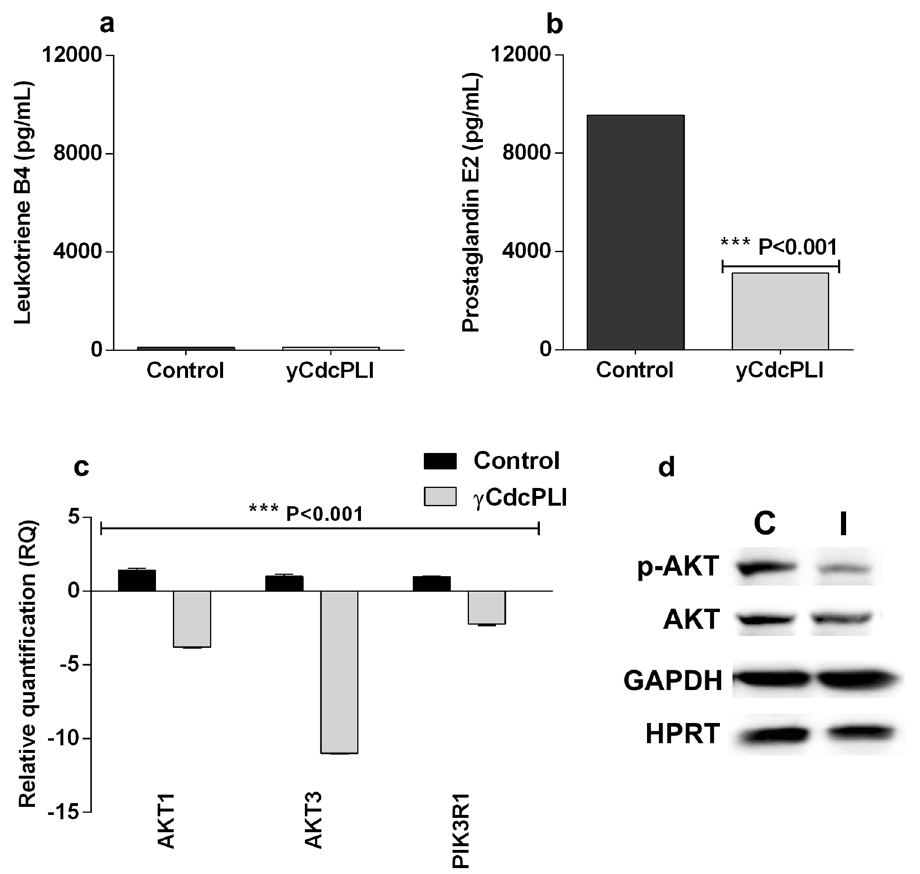
Figure 7. Prostanoid levels in MDA-MB-231 supernatants and modulation of PI3K/Akt pathway. ( a) Level measurements of prostanoids produced in MDA-MB-231. Leukotriene B4 and Prostaglandin E2 levels in MDA-MB-231 supernatant after treatment with γ CdcPLI at 25 µ g/mL. ( b) Relative quantification of genes and protein expressed in MDA-MB-231 cells treated with γ CdcPLI 25 μ g/mL (Akt1, Akt3 and PIK3R1). ( c ) Protein expression of p-Akt, Akt and the constitutive protein HPRT and GAPDH was used as housekeeping. All assays were carried out in triplicate; differences between treatments and controls were analyzed by Unpaired t-test. Statistically significant: *** p <